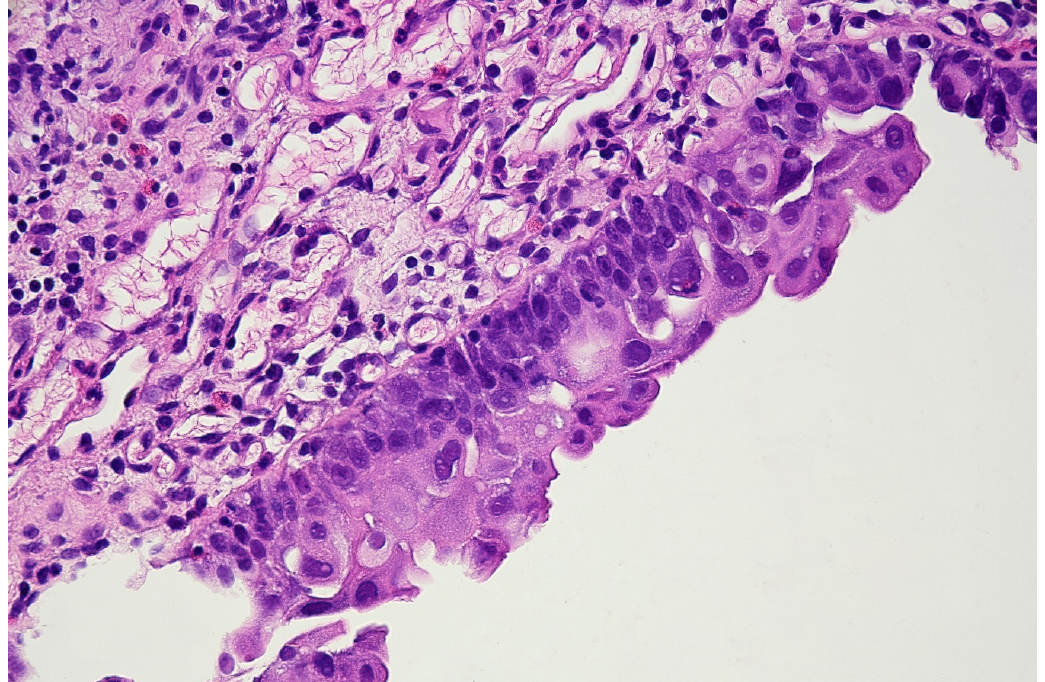
Figure 6. Histopathological specimen—Haematoxylin and Eosin (H&E) staining. The bladder is covered with the epithelium, the cells of which show features of severe atypia. Atypical cells are visible in all the layers of the epithelium, including the external surface. Locally, a reduced number of cell layers can be seen. Nuclei are present with marked anisokaryosis, hyperchromasia, and sometimes, with irregularity of the nuclear membrane. The unbroken basement membrane is visible along the entire length of the epithelium; there is no invasion of atypical cells. Occasionally, mitoses with atypical division figures can be noted.